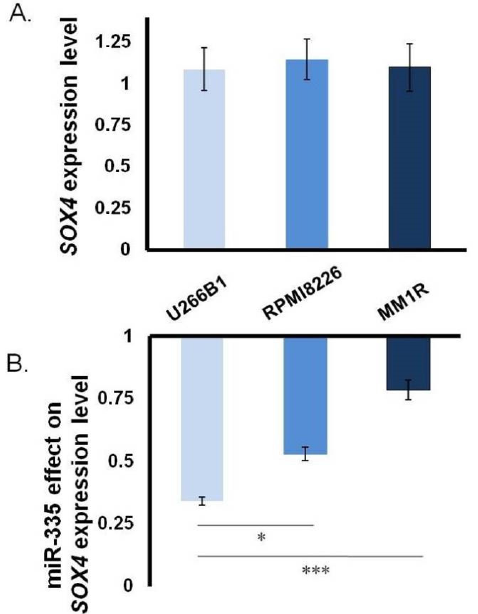
Figure 1. Analysis of SOX4 RNA expression in MM cells. ( A ) SOX4 expression level in MM cell lines evaluated by RT-qPCR. The HPRP1 gene was used as housekeeping gene. ( B ) The effect of 72 h transfection with pCMV-miR-335 on different MM cells lines on SOX4 RNA levels evaluated by RT-qPCR. ( p < 0.05 = *; p < 0.0005 = *** evaluated by t -test).